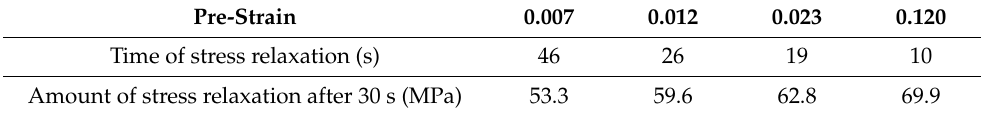
Table 5. The stress relaxation time and amount of stress relaxation according to the pre-strain.